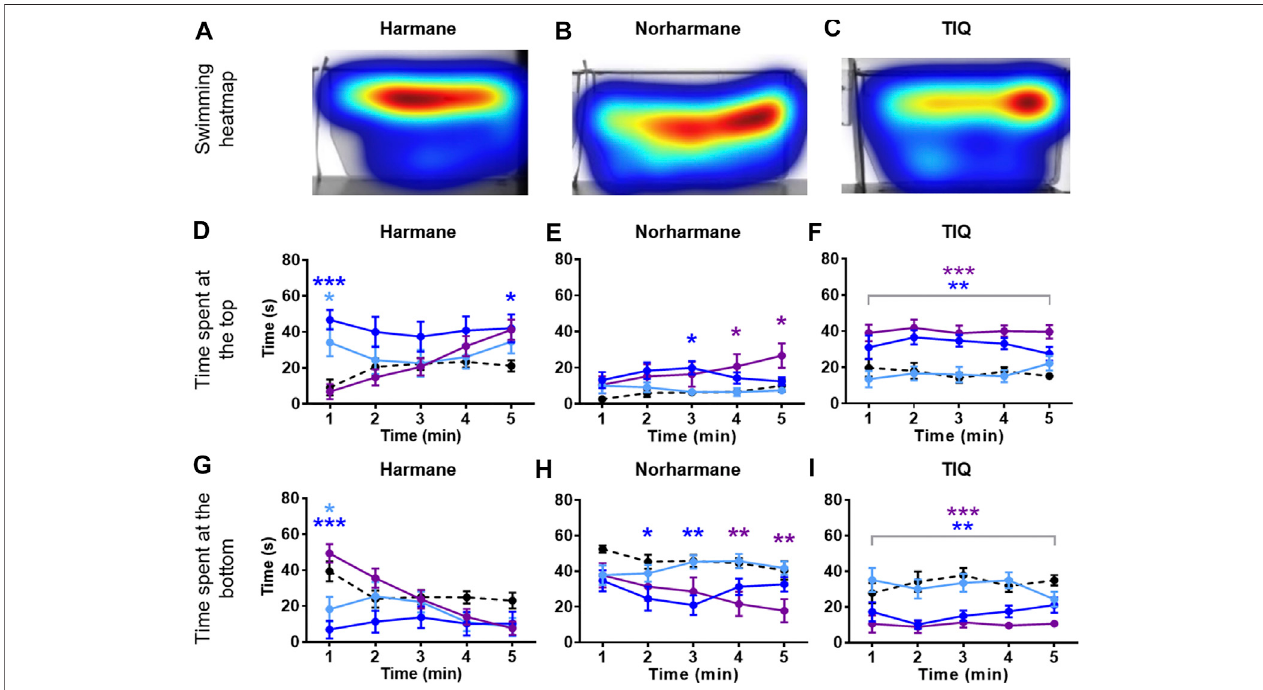
FIGURE 2 | NTT results for harmane, norharmane, and TIQ. Representative heatmaps for (A) harmane (3 mg/L) (B) norharmane (3 mg/L), and (C) TIQ (100 mg/L) duringtheNTTforonezebra fi shpercompoundareshown.Theheatmapsshowtheminimum(darkblue)tomaximum(darkred)amountoftimea fi shspentineachpixel. Timespentatthetopandthebottomofthetankarequanti fi edfor (DandG) harmane(1,3,and10 mg/L), (EandH) norharmane(0.3,1,and3 mg/L),and (FandI) TIQ (10, 30, and 100 mg/L). Allcompoundsshowanxiolytic-likeeffectsatatleastoneoftheconcentrationsandtimepoint.Blackdashedline (cid:1) vehiclecontrol;lightblue (cid:1) lowest concentration; blue (cid:1) middle concentration; purple (cid:1) highest concentration. The sample size was 12 except for 10 mg/L harmane, control group for norharmane, 3 mg/L norharmane, and 100 mg/L TIQ, which were n (cid:1) 11. Dataare expressed asmean ± SEM. * p < 0.05; ** p < 0.01; *** p < 0.001;Abbreviations:NTT (cid:1) novel